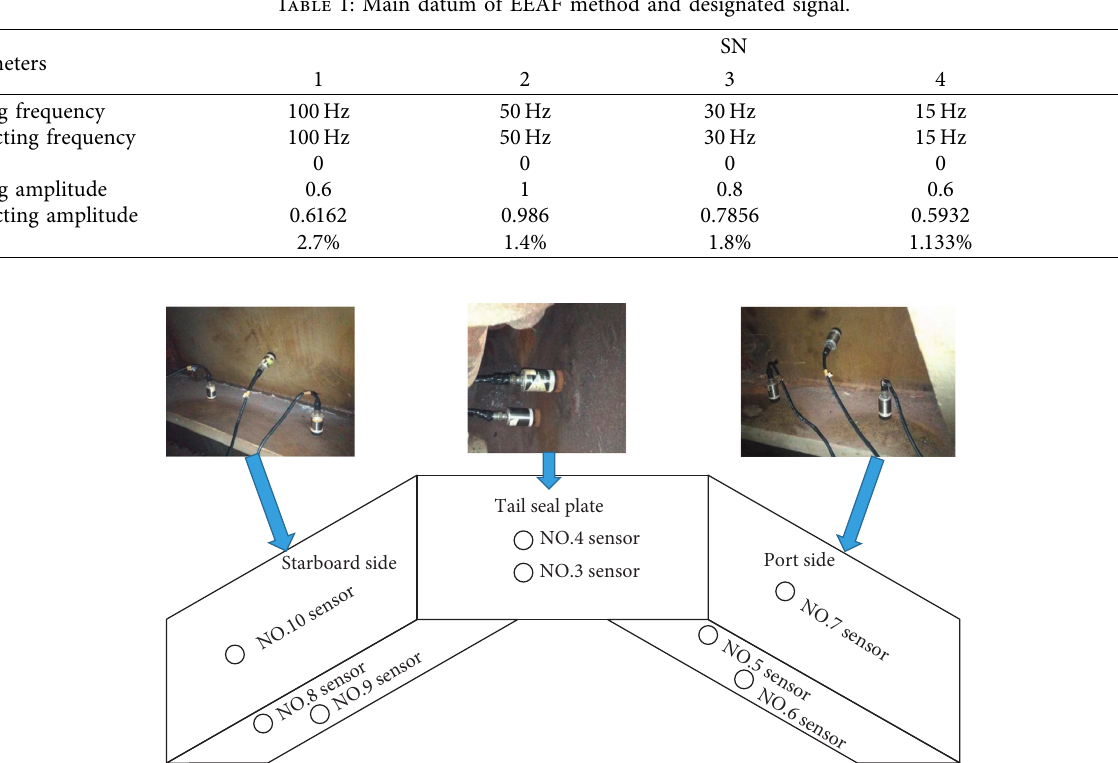
Figure 8: Arrangement of sensors during hull vibration